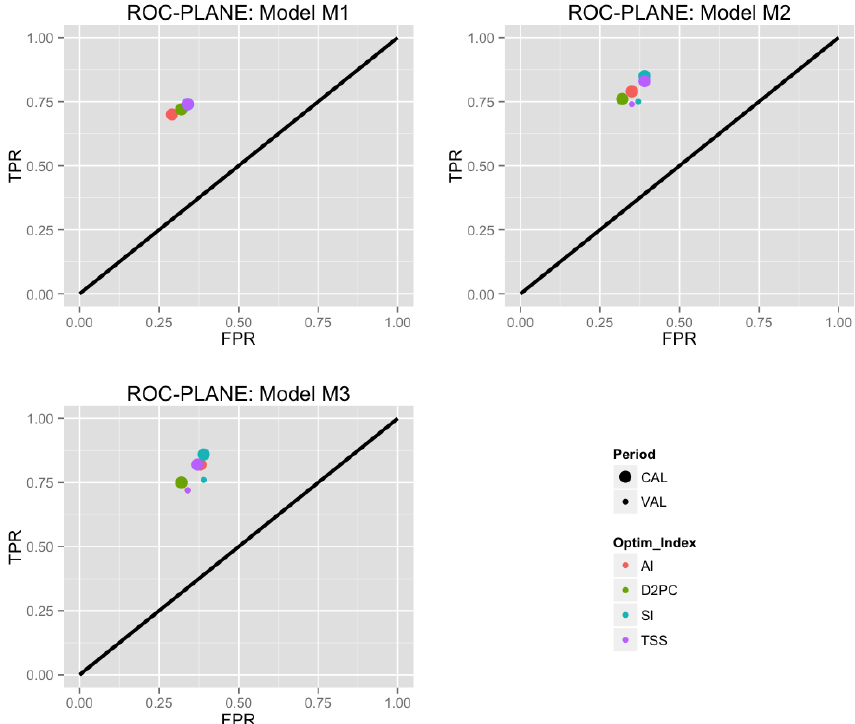
Figure 3. Models’ performance results in the ROC plane for M1, M2, and M3. Only GOF indices whose optimization provides FPR<0.4 and TPR>0.7 were